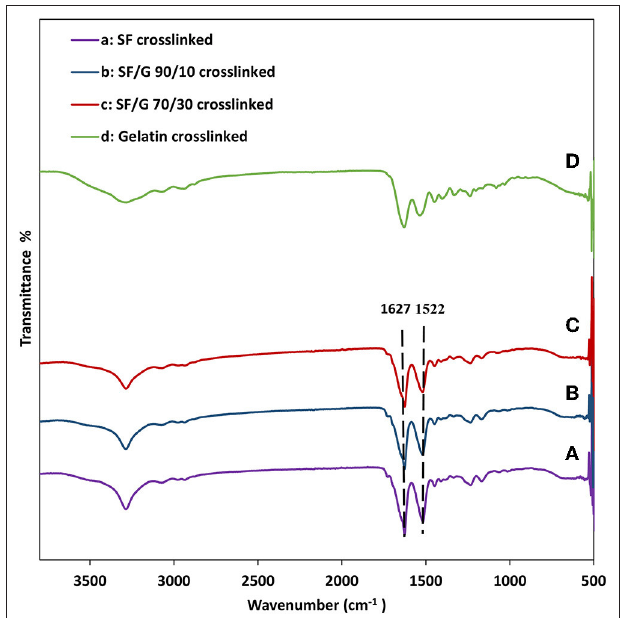
FIGURE 4 | FTIR spectra of GTA crosslinked nanofiber mats: (A) SF, (B) SF/gelatin at the blend ratio of 90/10, (C) SF/gelatin at the blend ratio of 70/30, and (D) gelatin. “SF/G” represents silk fibroin/gelatin.